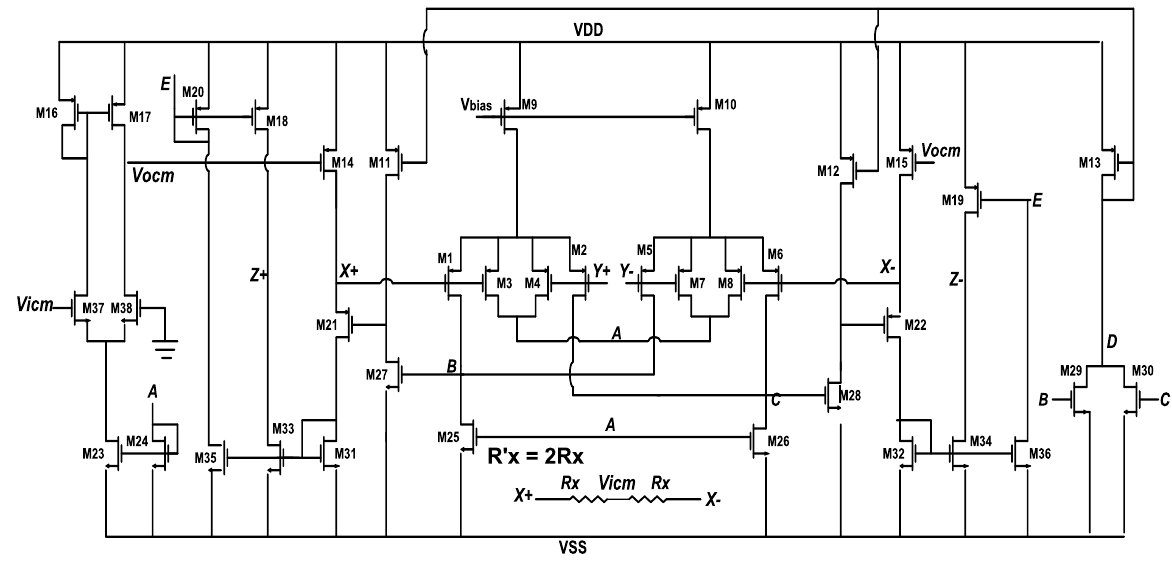
Figure 2. Transistor level structure for proposed